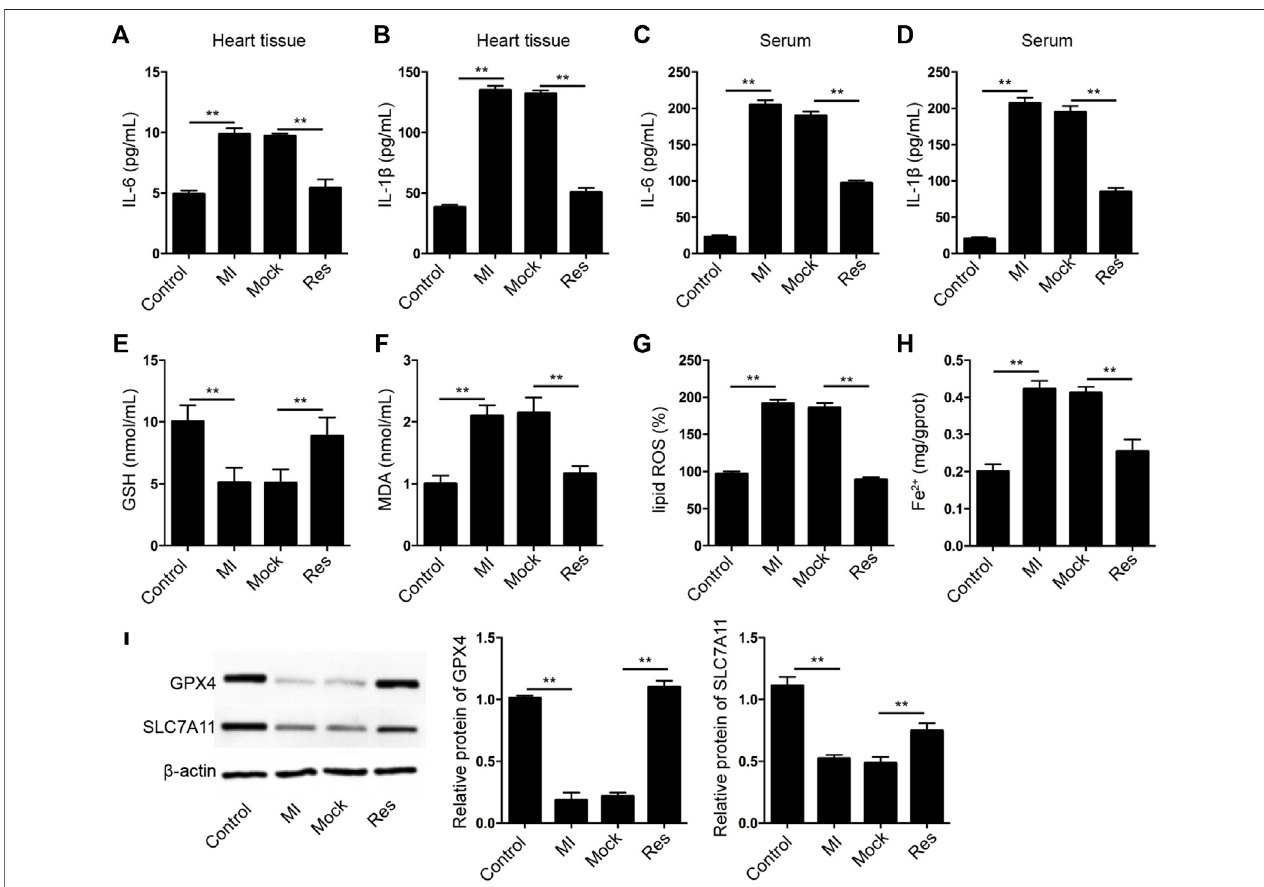
FIGURE2|Resalleviatesin fl ammationandferroptosisinMIrats.(A – I) TheMIratswereinjectedwithRes( n =5foreachgroup). (A – D) ThelevelsofIL-6and IL-1 β were measured by ELISA assay in heart tissues and serum samples of the rats. The levels of GSH (E) , MDA (F) , lipid ROS (G) , and Fe 2+ (H) were analyzed. (I) The expression ofGPX4 and SLC7A11was detected byWesternblot analysis and was normalized on the expression of β -actin. Data arepresented asmean ± SD. Statistic signi fi cant differences were indicated: ** p < 0.01.